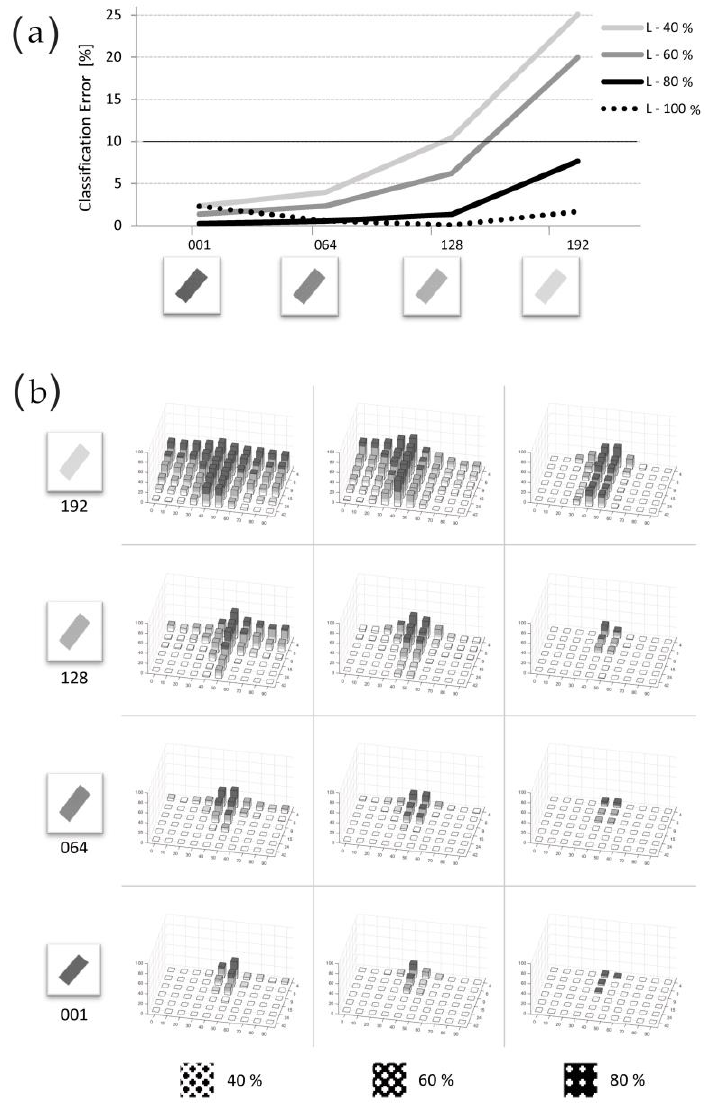
Figure 8. Textured Bars on uniform Background: Large granularity texture. Results of the second group of tests, in which HMAX was assessed when working on textured elements on uniform background. Results here presented refer to the Large granularity texture (8 pixels in diameter). ( a ) Mean values for the twelve experimental conditions (4 Luminance × 3 Density conditions). The three texture densities are represented by three solid lines (80%, 60% and 40%); the dotted line reports the result from previous tests (uniform filling is equal to 100% density; some values are obtained by interpolation). The four Luminance conditions are reported on the x-axis (respectively 001, 064, 128 and 192 #Lum). ( b ) Detailed results for the twelve different Texture conditions (4 Luminance—in row, and 3 densities—in column). In each histogram, X and Y axes report, respectively, the ten orientations and the six sizes characterizing each item, as previously presented in Figure 3. Diagrams show that HMAX is less performing with large texture, and performances become even worse if less information is available (i.e. when bars become smaller, or lighter).